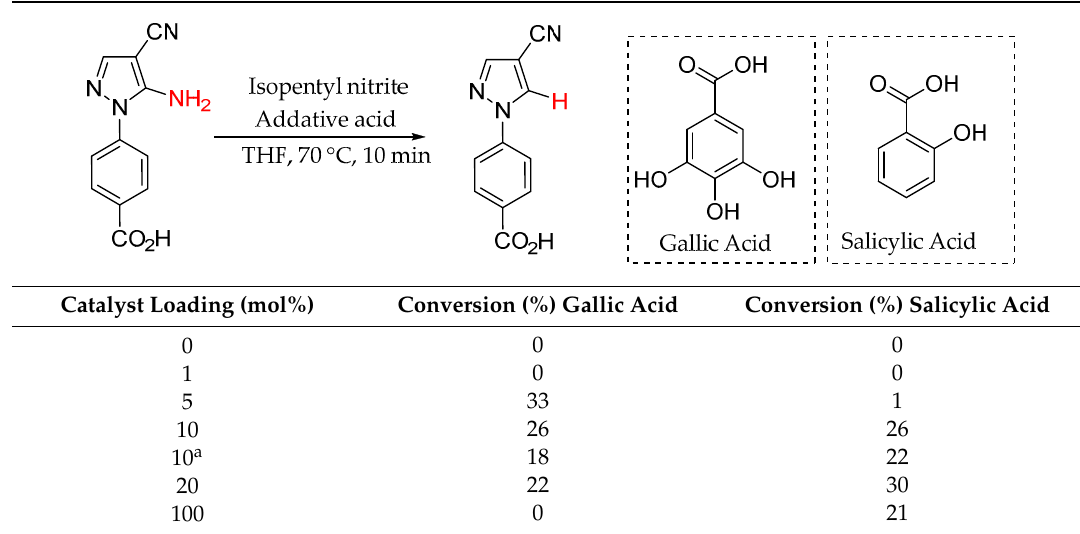
Table 5. Conversion of 4-(5-amino-4-cyano-1 H -pyrazol-1-yl)-benzoic acid ( 1u ) to 4-(4-cyano-1 H - pyrazol-1-yl)-benzoic acid ( 2u ) with various quantities of gallic and salicylic